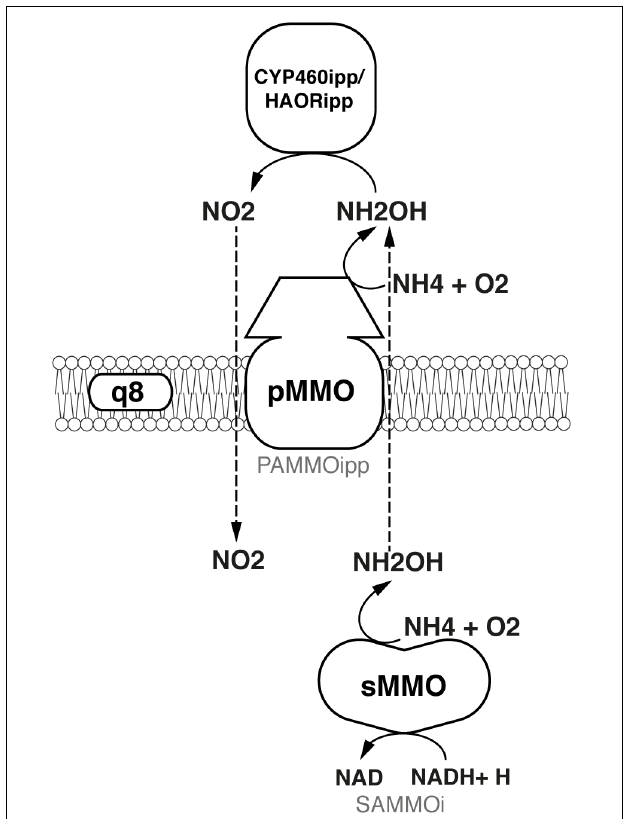
FIGURE 5 | Oxidation of ammonia to